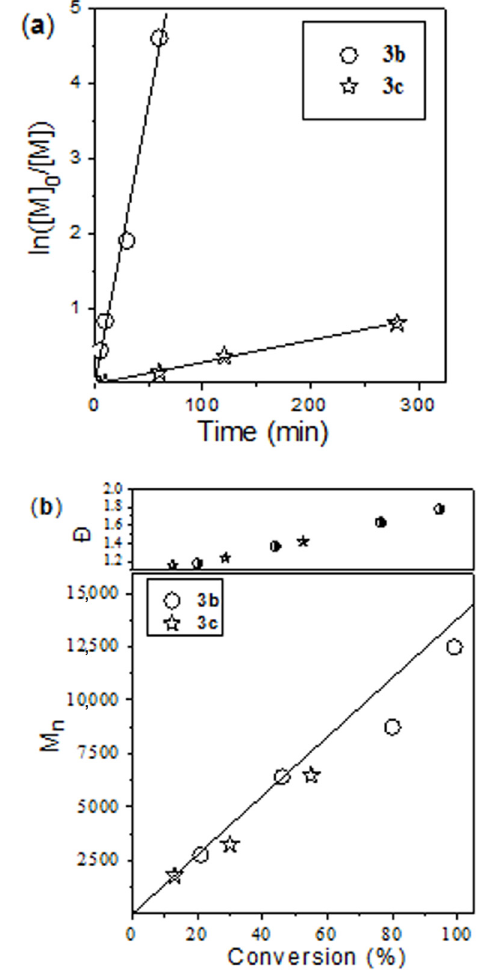
Figure 5. ( a ) ln[ M ] 0 /[ M ] vs. time; ( b ) M n , Ð vs. conversion dependences for the bulk D , L -lactide polymerization at 130 ◦ C and [ M ]/[catalyst] = 100 for different catalytic complexes. The straight line in Figure 5b corresponds to the theoretical molecular weight calculated as M n (theor)= ([ D , L -lactide]/[catalyst]) × 144 × Conversion + 115. Experimental values of the molecular weight determined by SEC versus polystyrene standards were corrected by a factor of 0.58 [85].